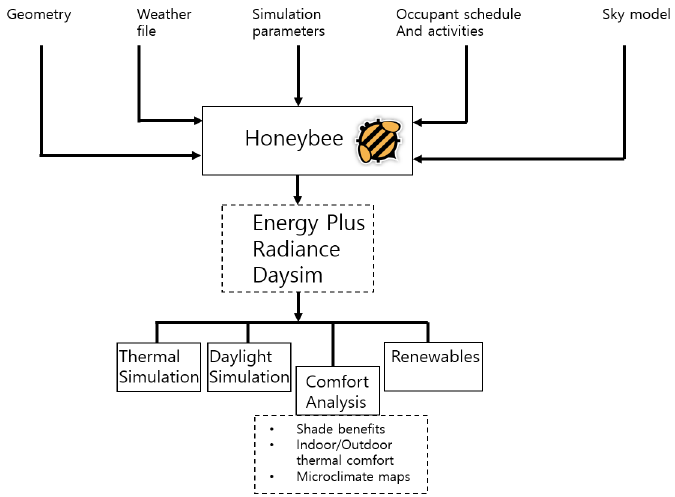
Figure 11. Honeybee Workflow and functions.